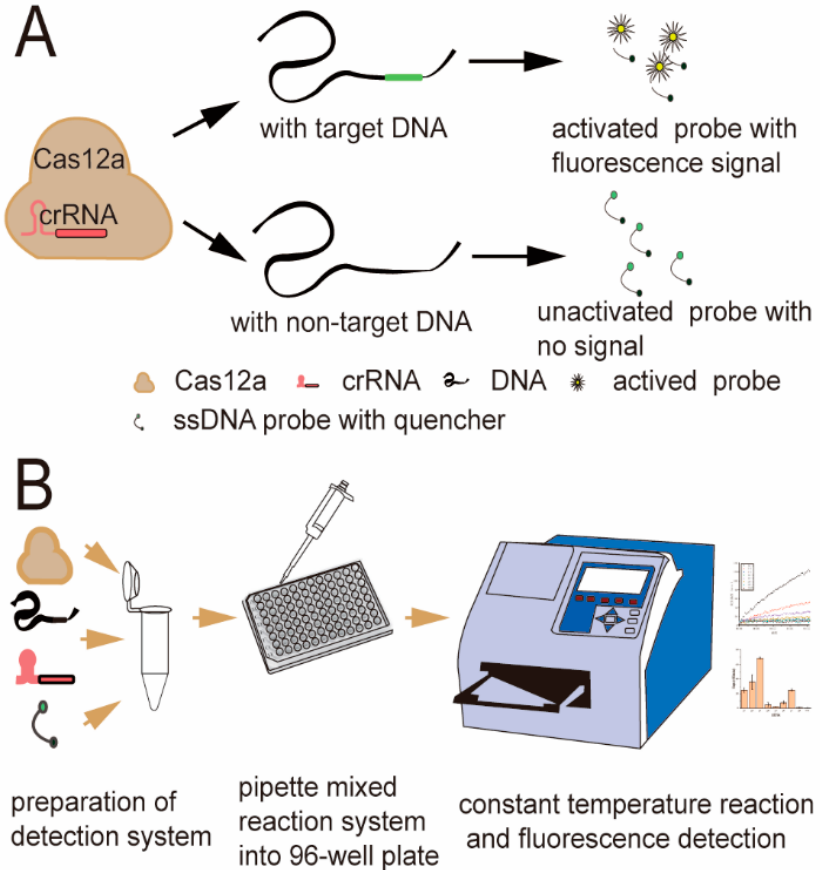
Figure 1. Schematic diagrams of fluorescence generation ( A ) and workflow ( B ) of target DNA detection based on the CRISPR-Cas12a system.